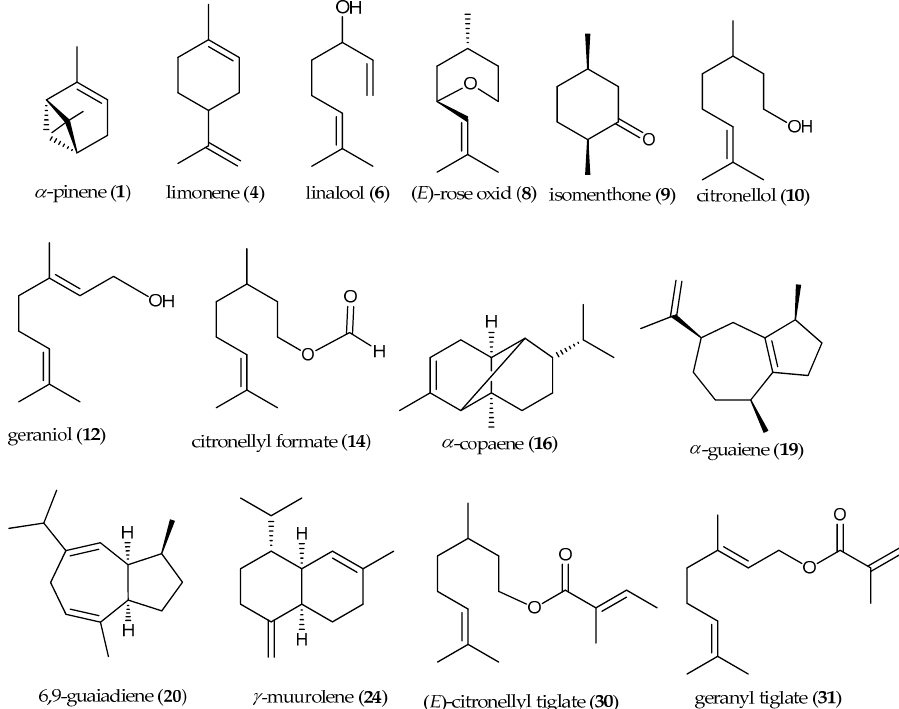
Figure 2. Main chemical compounds of P. graveolens .